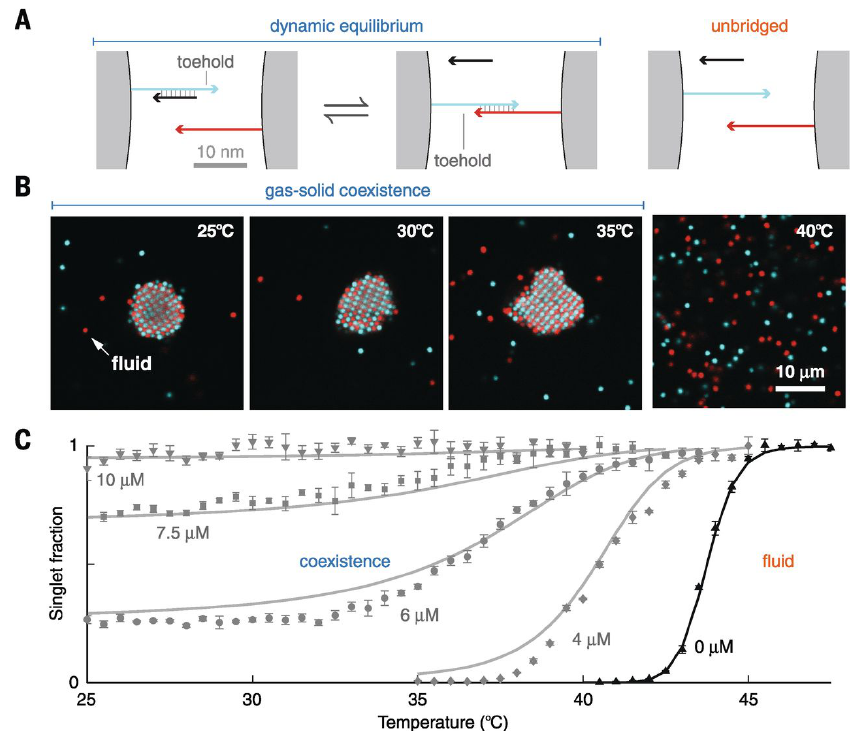
Figure 7. ( A ) shows the schematic representation of the strand displacement between the particles. ( B ) shows the confocal fluorescence micrograph of a binary suspension of DNA-grafted particles at different temperatures. ( C ) shows the singlet fraction for various concentrations of displacing strands; one can see the broadening of melting transition with increasing concentration of displacing strands. From [90], reprinted with permission from